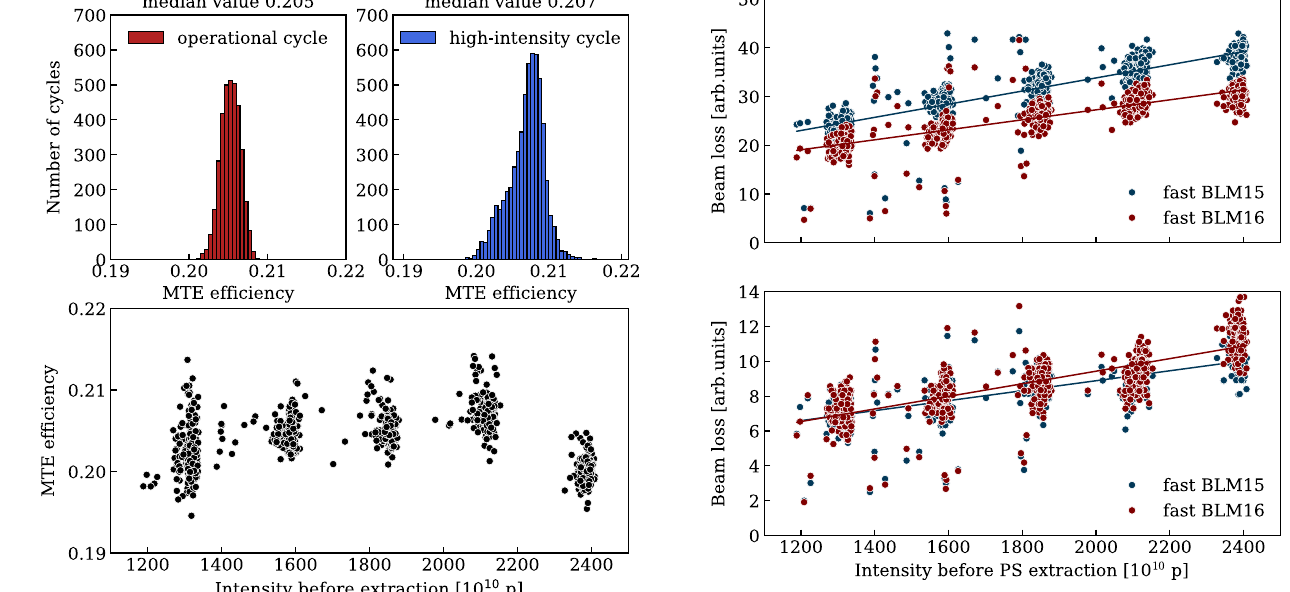
FIG. 10. Upper: Distribution of MTE efficiency for the opera- tional (left) and the high-intensity variant (right). The high- intensity data refer to the three-day period on November 11, when the MTE beam with an intensity of about 2 . 4 × 10 13 protons was delivered to the SPS for the fixed-target physics (see also Fig. 7, bottom). The median of the distribution is essentially the same, while a low-efficiency tail is present for the high-intensity beam. Lower: MTE efficiency for various beam intensities. These data refer to a special test that took place on November 15 for about 9 hours, without performing any beam optimization at each intensity step.